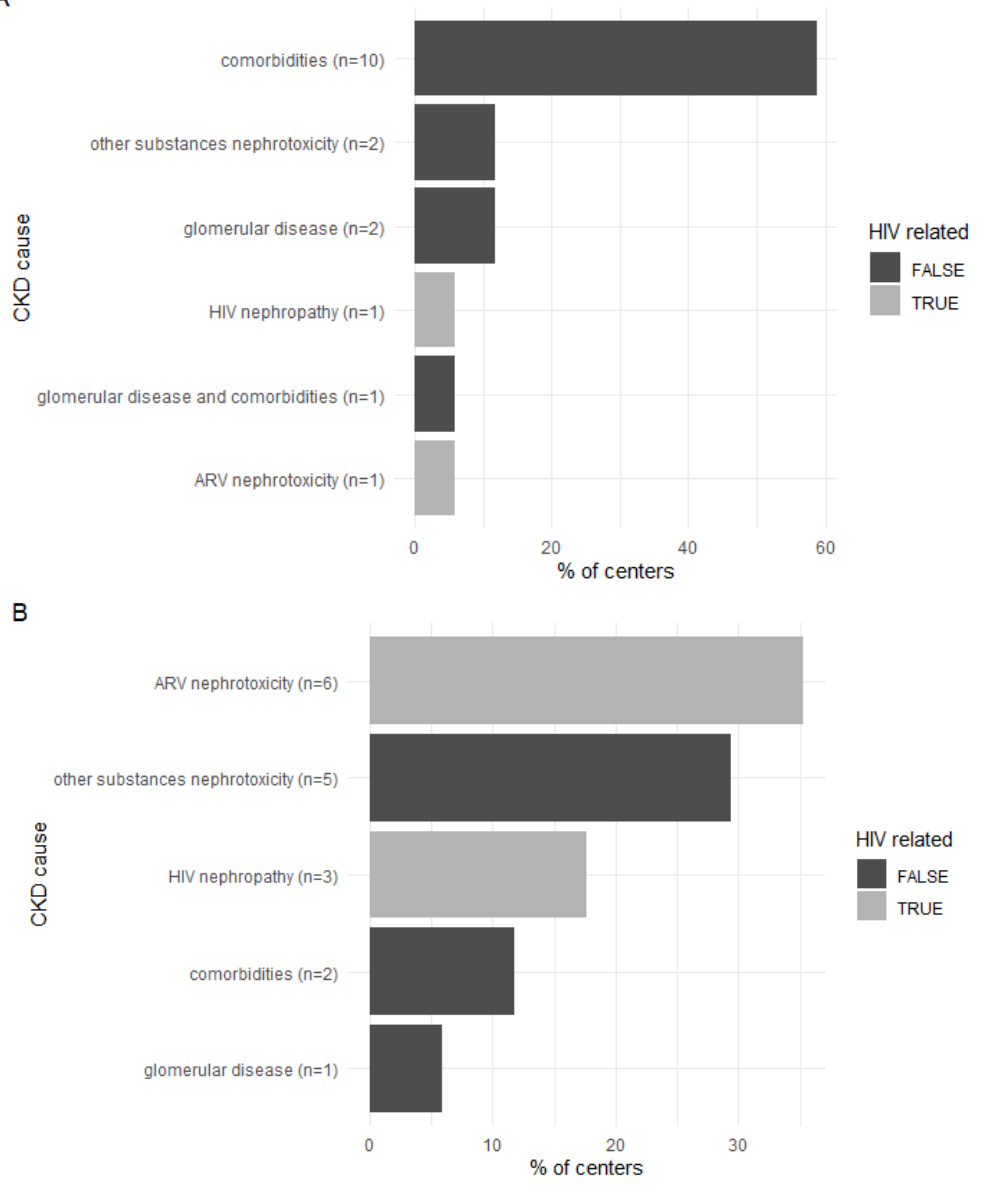
Figure 1. Availability of diagnostic tests.